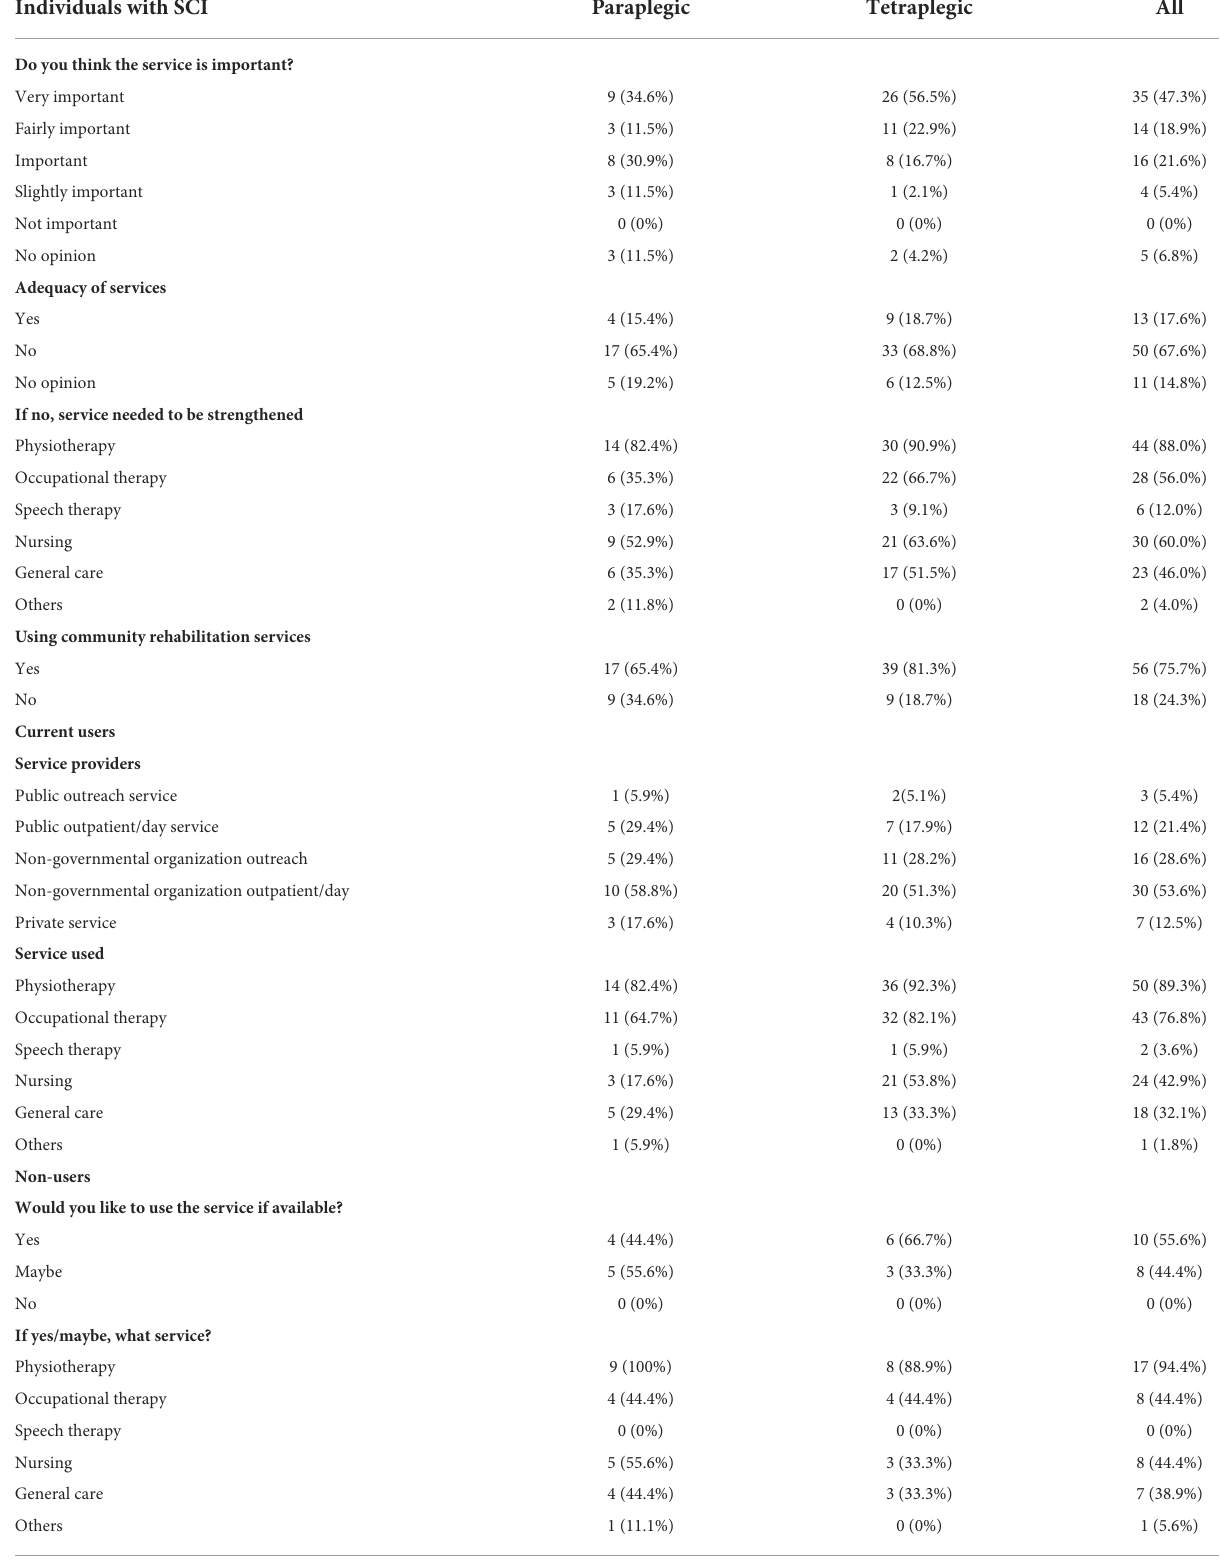
TABLE 6 Opinions on community rehabilitation services. Individuals with SCI Paraplegic Tetraplegic